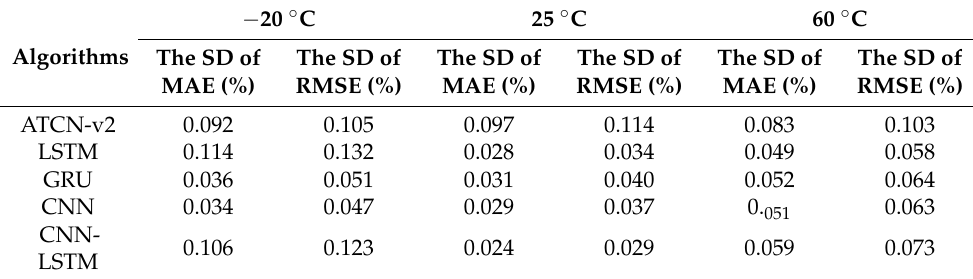
Table 6. The stability of algorithms under different